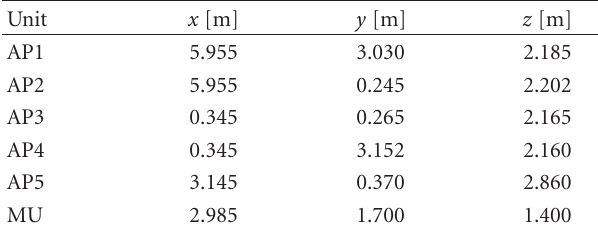
Figure 13: Distribution of the PDOP values (top view) in the simulation and measurement scenario. Red dots represent the AP positions. The yellow dot represents the position of the MU from E1, and magenta those from E2. The arrows show the alignment of the antennas in the E2. Table 2: Positions of the T - R units in the scenario in E1.